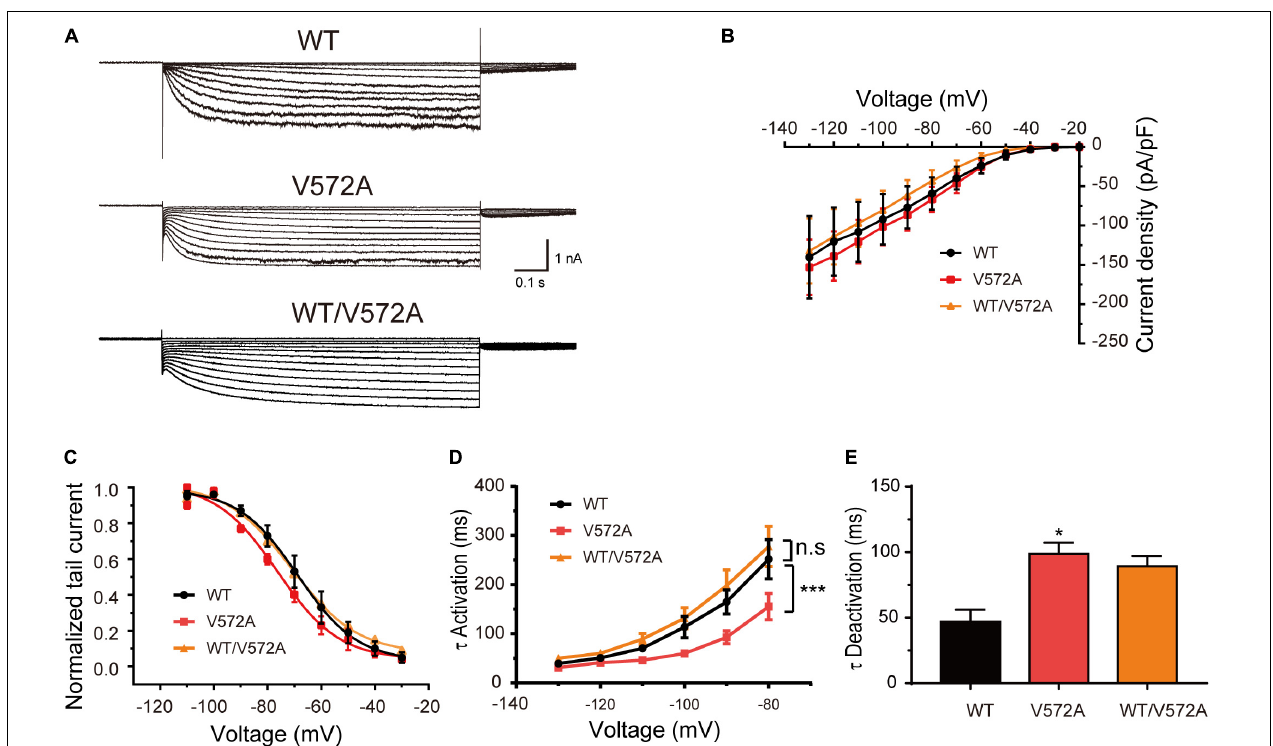
FIGURE 5 | Functional changes of the V572A variant. (A) Representative traces of WT, V572A, and WT/V572A channels. (B) Plot of mean current densities of WT ( n = 11), V572A ( n = 10), and WT/572A channels ( n = 14). Two-sample t- test. (C) Voltage-dependent activation curves of WT channels ( n = 9), V572A ( n = 11), and WT/572A channels ( n = 8). Analysis was done by two-sample t -test. (D,E) Summaries of mean activation time constants (WT: n = 16; V572A: n = 8; WT/V572A n = 11) and deactivation constants (WT: n = 10; V572A: n = 9; WT/V572A n = 12) for WT, V572A, and WT/572A. Analysis was done by two-sample t- test. * P < 0.05, *** P <